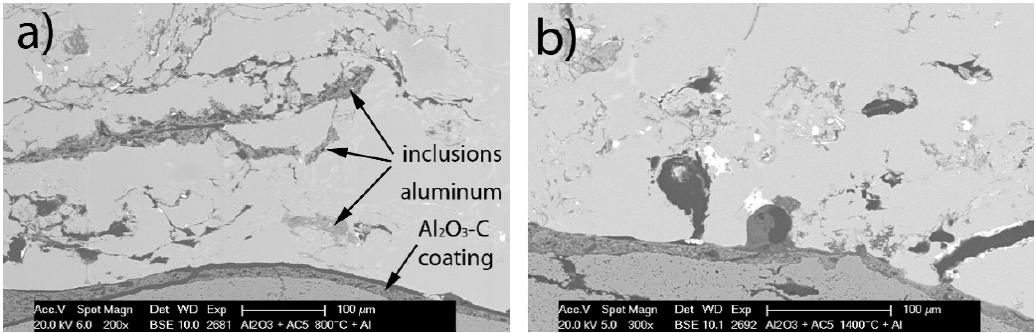
Figure 6. SEM micrographs of the ( a ) Al 2 O 3 -C 800 °C and ( b ) Al 2 O 3 -C 1400 °C after casting of AlSi7Mg with non-metallic inclusions .